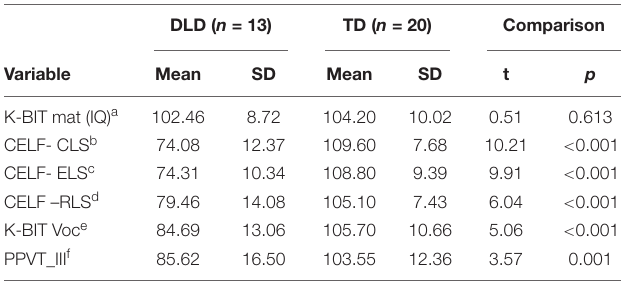
TABLE 2 | Standardized scores for language, cognitive assessment measures for children with Developmental Language Disorder (DLD) and typically developing (TD) children measured at wave 1 (Study 1).